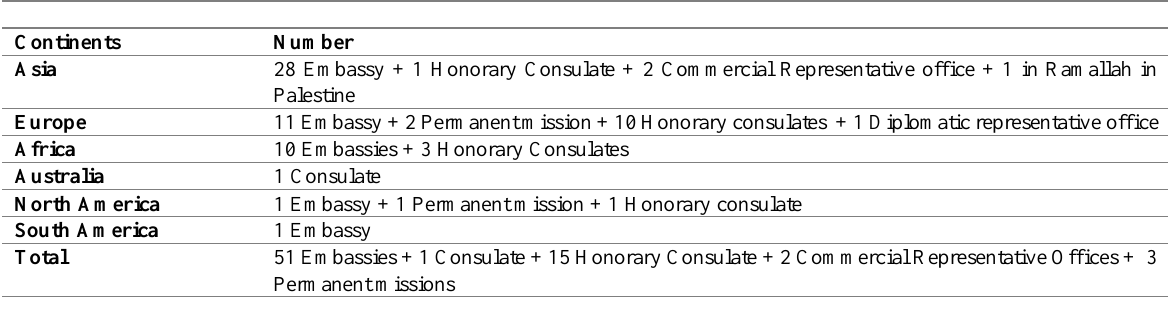
Table 1: Oman’s diplomatic missions abroad